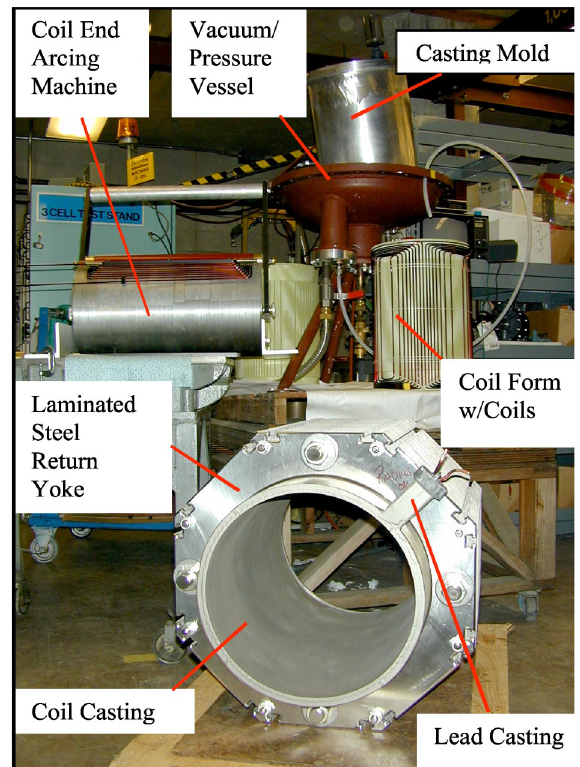
FIG. 19. (Color) Photograph of an NTX magnet during